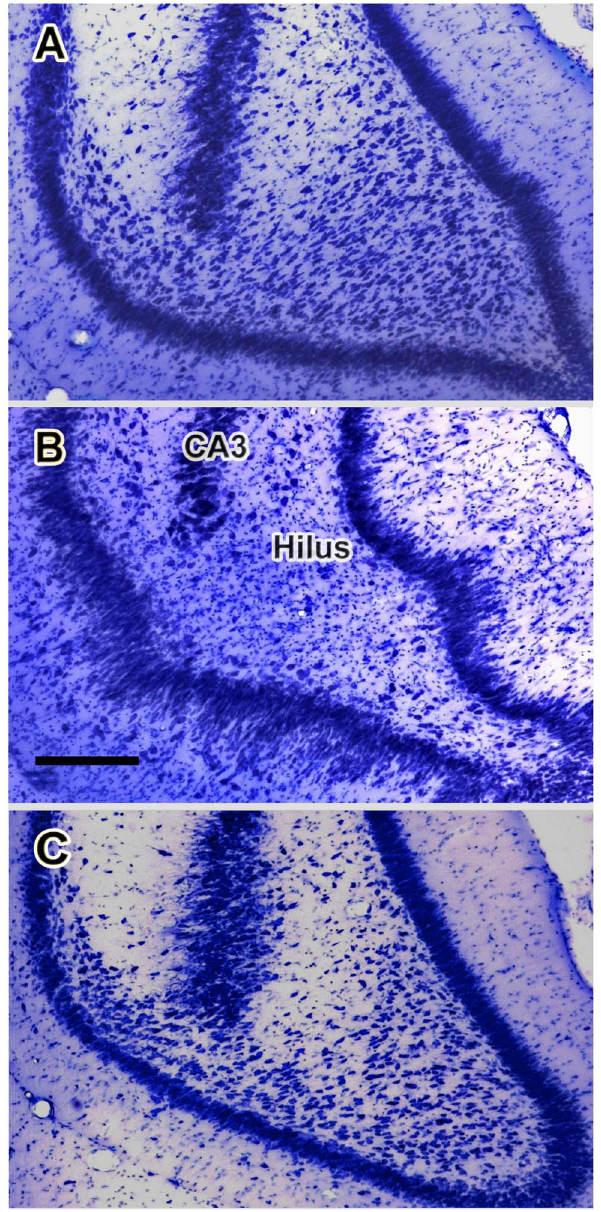
Figure 6. Kainate-induced loss of neurons in the ventral dentate hilus. Photomicrographs of representative Nissl-stained coronal sections containing the ventral portion of the dentate gyrus taken from a control rat ( A ), from a rat in the behavioral status epilepticus (BSE) group ( B ) and from a kainate-treated rat that had not experienced behavioral status epilepticus (no-BSE; C ). Note that the density of neurons in the dentate hilus is dramatically reduced in the rat that experienced behavioral SE ( B ). In striking contrast, most of the neurons of the ventral hilus are preserved in the rat from the no-BSE group ( C ). Scale bar shown in ( B )=250 m m. doi:10.1371/journal.pone.0084722.g006 savings and percentage of time in the training quadrant, respectively; Fig. 8C, D). In contrast, we found no significant correlations between the two behavioral indexes and the total number of the CA1 pyramidal neurons (Fig. 8E, F).